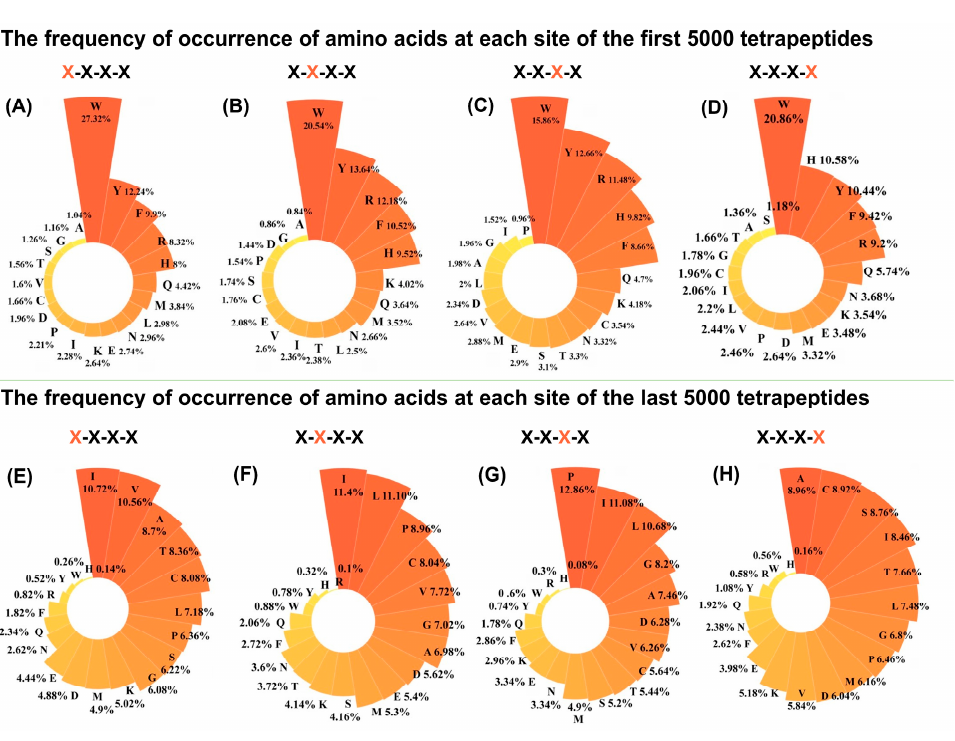
Figure 1. The frequency of occurrence of amino acids at each site of the first 5000 and the last 5000 tetrapeptides. The first 5000 tetrapeptides ( A ) N-terminal; ( B ) N-terminal second position; ( C ) N- terminal third position; ( D ) C-terminal. The last 5000 tetrapeptides ( E ) N-terminal; ( F ) N-terminal second position; ( G ) N-terminal third position; ( H ) C-terminal. Table 1. Potential ACE inhibitory peptides IC 50